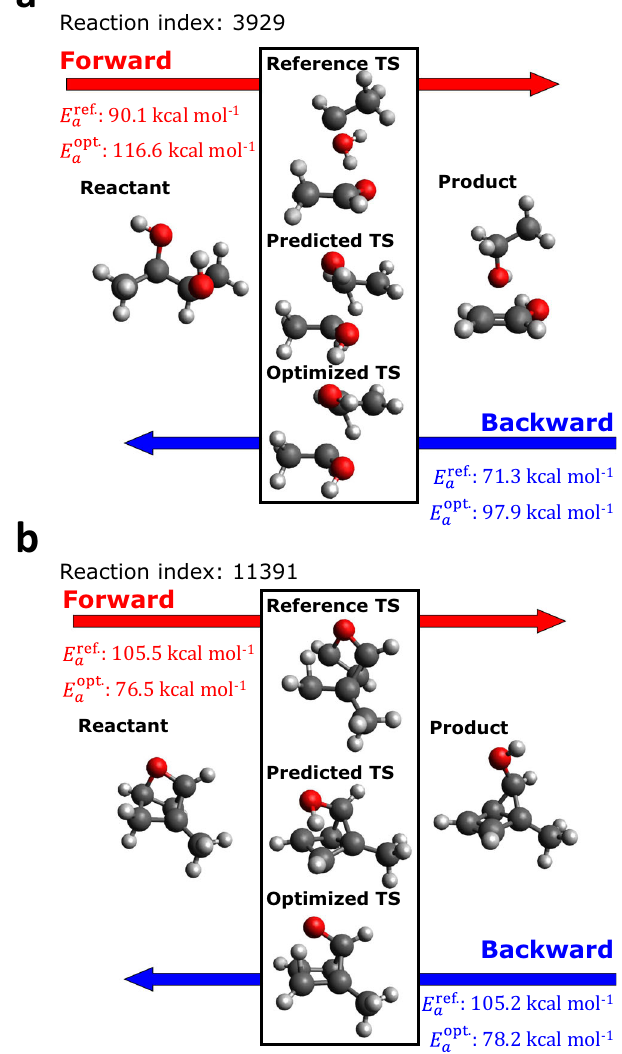
Fig. 4 | Molecular structures and activation barriers for extreme cases. Reac- tant,product,andtransitionstateshaving a themostpositiveand b most-negative energy errors among the inferred structures that yielded correct reactant and product structures through intrinsic reaction coordinate calculations. A positive (or negative) error indicates that the obtained transition state structure is ener-